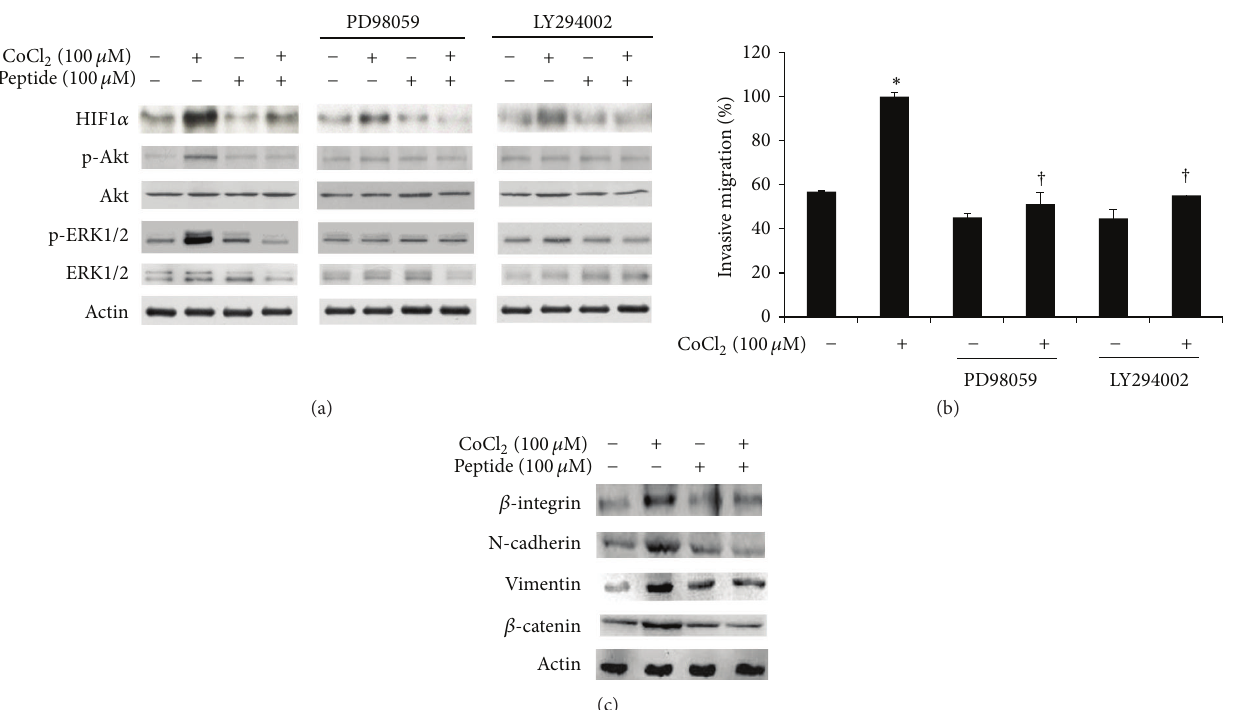
Figure 4: S. maxima peptide suppresses the HIF1 𝛼 signaling pathway necessary for CoCl 2 -induced invasive migration in HT1080 cells. (a) HT1080 cells were incubated with 100 𝜇 M CoCl 2 and/or 100 𝜇 M peptide for 24 h in the presence or absence of PI3K inhibitor, 10 𝜇 M LY294002 or ERK inhibitor, and 10 𝜇 M PD98059. Cell lysates were prepared, and the expression level of HIF1 𝛼 and phosphorylation levels of Akt and ERK1/2 were examined by western blot analysis. Representatives of 3 independent experiments are shown. (b) Cells were prepared as in (a). Invasive migration of HT1080 cells was examined. All data are presented as mean ± S.D. ∗ 𝑃 < 0.05 compared with blank without CoCl 2 stimulation; † 𝑃 < 0.05 compared with CoCl 2 control. (c) HT1080 cells were incubated with or without 100 𝜇 M CoCl 2 and 100 𝜇 M peptide